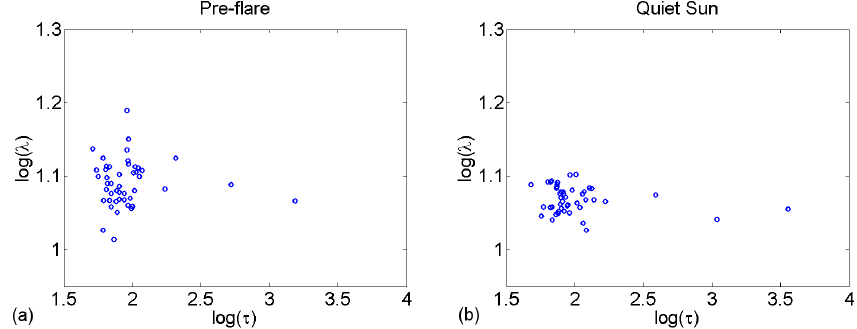
Figure 8. Length scale vs. timescale for all POD ranks: (a) pre-flare and (b) quiet Sun.